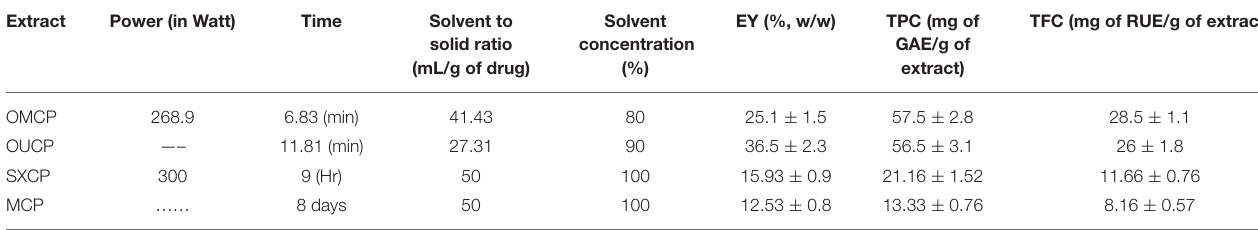
TABLE 3 | Comparative evaluation of different extracts of CP Willd for EY, TPC, and TFC. Extract Power (in Watt) Time Solvent to